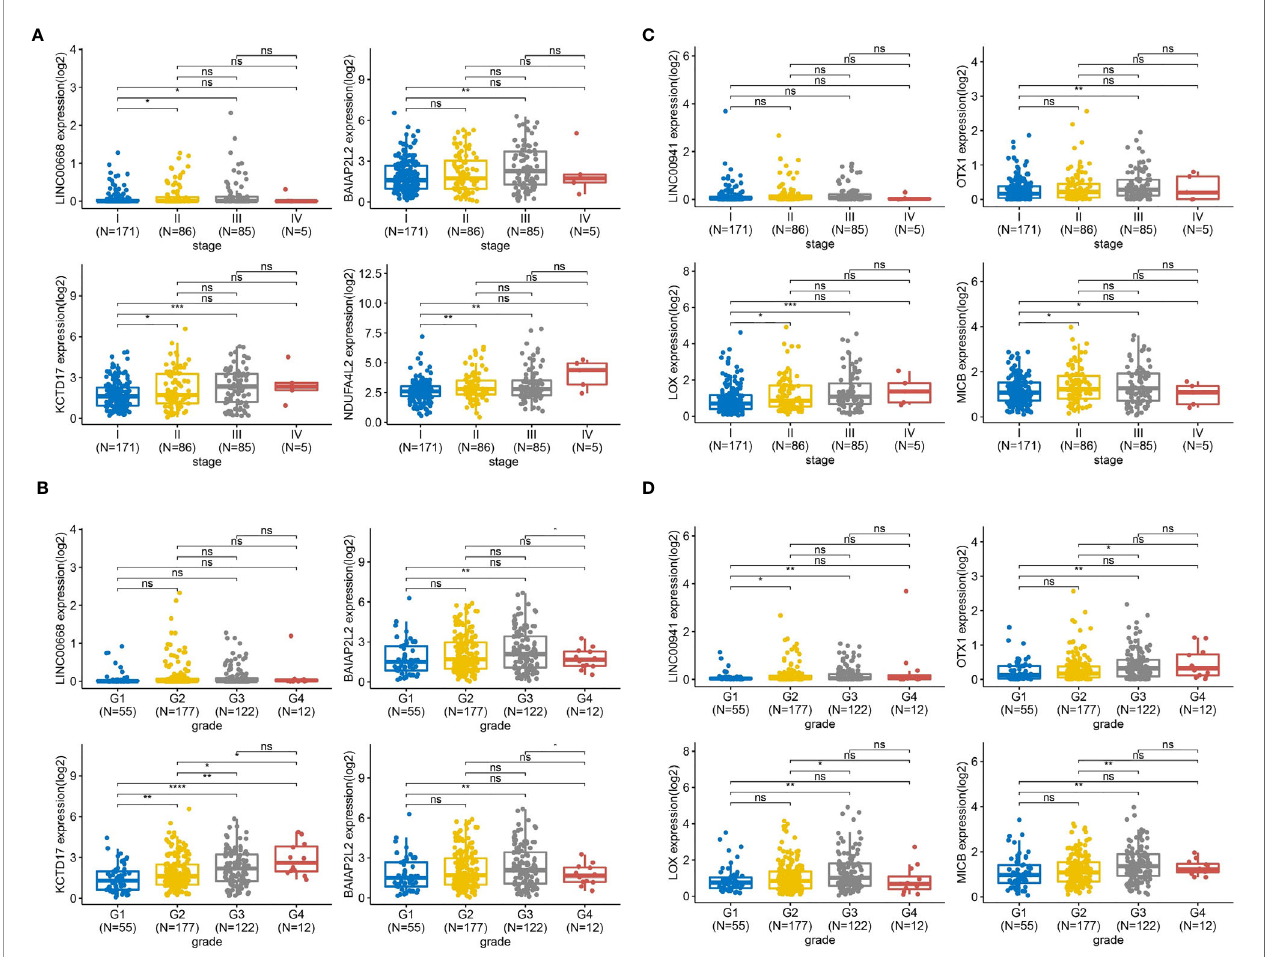
FIGURE 8 | The expression levels of the two group genes in HCC patients across different TNM stages and tumor grade. (A) TNM stages analysis based on the expression level of LINC00668 and its co-expression mRNA in 347 HCC patients from TCGA. (B) Tumor grade analysis based on the expression level of LINC00668 and its co-expression mRNA in 366 HCC patients from TCGA. (C) TNM stages analysis based on the expression level of LINC00941 and its co-expression mRNA in 347 HCC patients from TCGA. (D) Tumor grade analysis based on the expression level of LINC00941 and its co-expression mRNA in 366 HCC patients from TCGA. (*P < 0.05, **P < 0.01, ***P < 0.001, ****P < 0.0001; NS, not signi fi